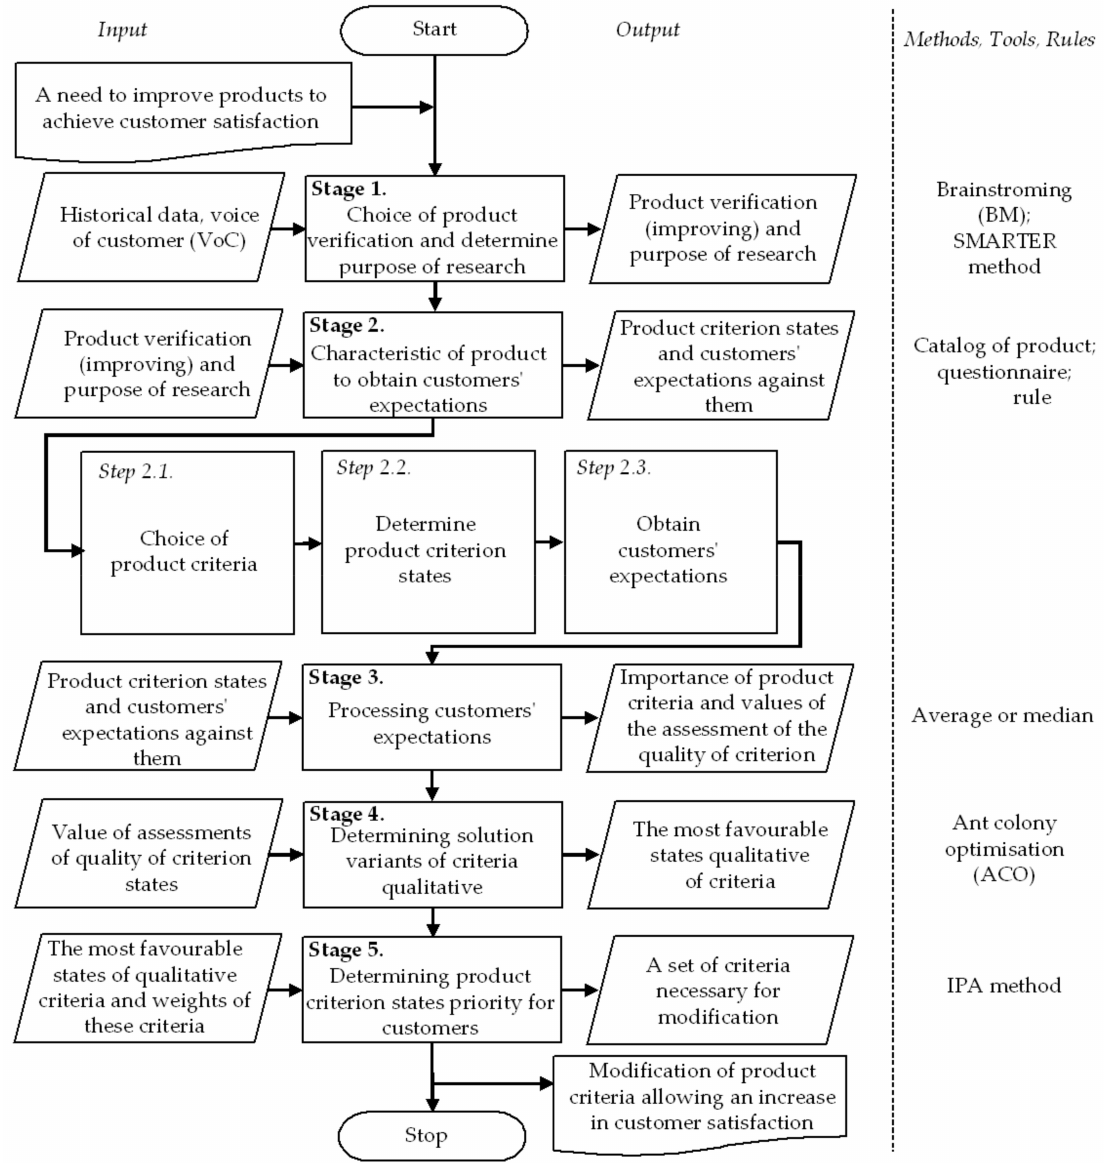
Figure 2. Framework of the proposed model supporting the selection of heat pumps with significant consideration of customer